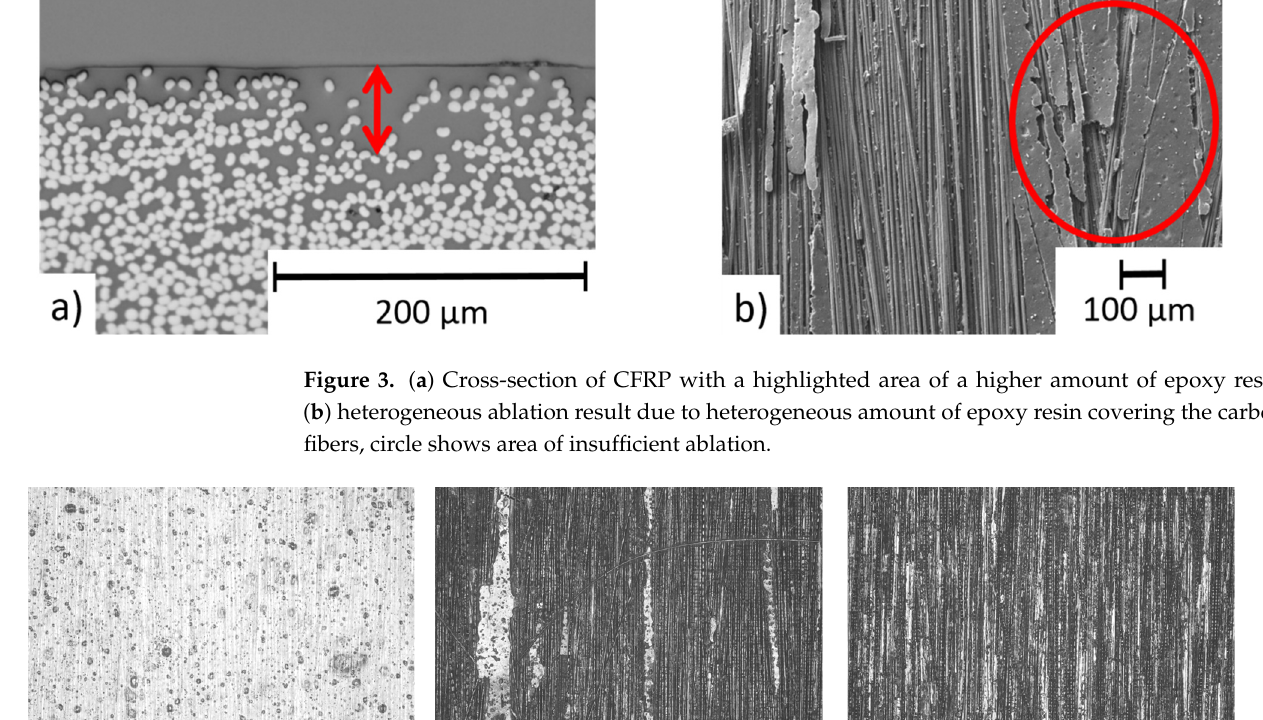
Figure 4. Optical microscope images of three surface qualities after laser pre-treatment with ( a ) in- sufficient, ( b ) optimal, and ( c ) damaging material removal.